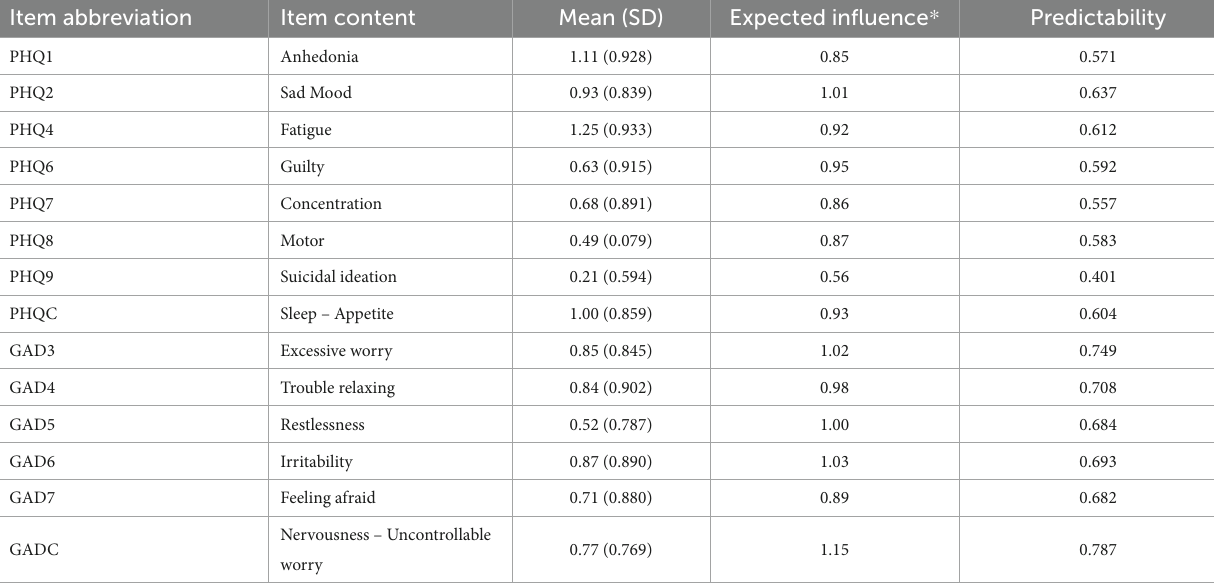
TABLE 2 Descriptive statistics of depressive and anxiety symptoms in Macau